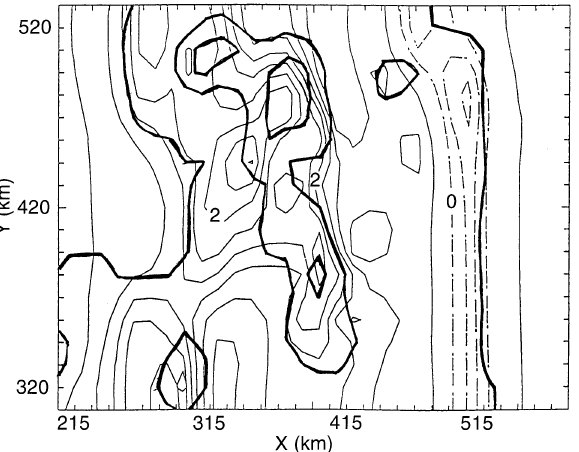
Fig. 4. Surface u (cid:120) field in m/s after 120 min for SET I, contour line interval 0.5 m/s. The topography is outlined in bold at intervals of